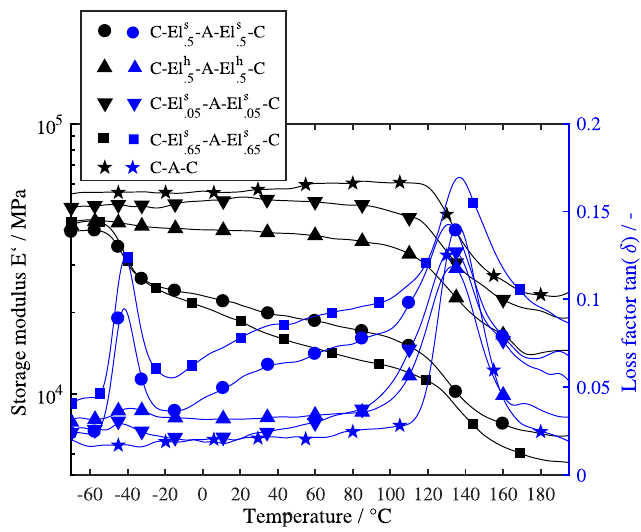
Figure 5. 3PB Temperature sweep at 1Hz for all lay-ups with CFRP on the outside. The solid lines are fitted to the measurement steps every 2.5 ◦ C from − 70 ◦ C to +200 ◦ C and every 5 ◦ C from − 20 ◦ C to 200 ◦ C. For better visibility, only a few markers are displayed in addition to the fitted solid lines.